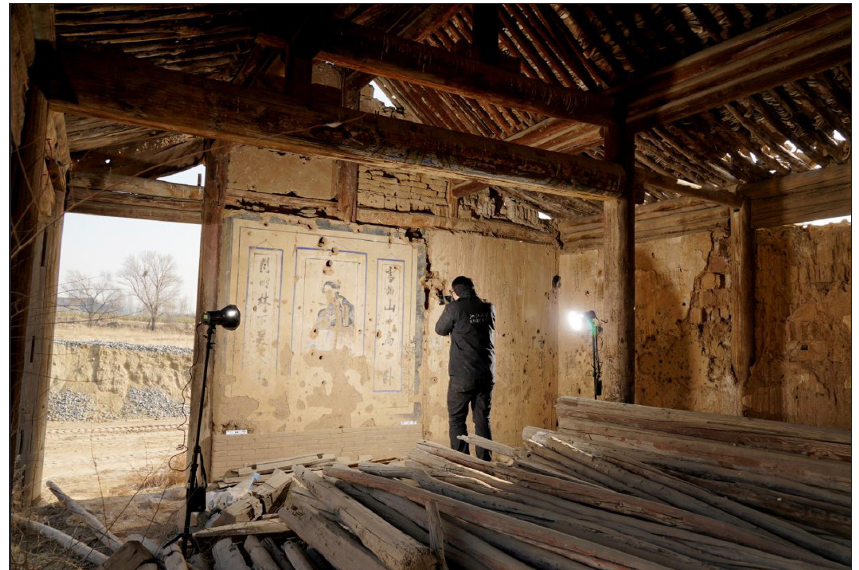
Figure 2: SDDP field team in action: recording Dingxiang Temple. The field work condition can be rather rough, as the local temperature can drop to –20°C in the winter and rise over 40°C in the summer. Photo courtesy of the SDDP team.